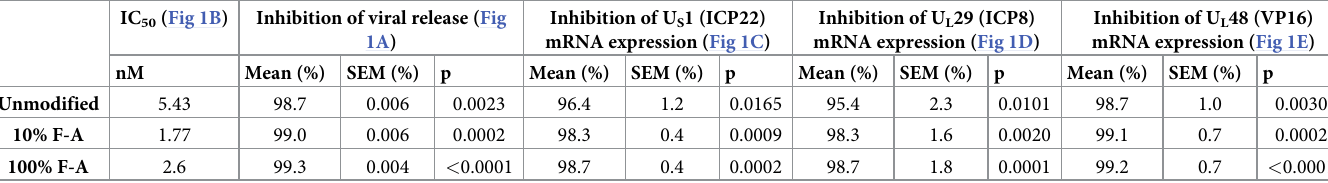
Table 2. Antiviral activity of UL29 siRNA swarms in HCE cells a